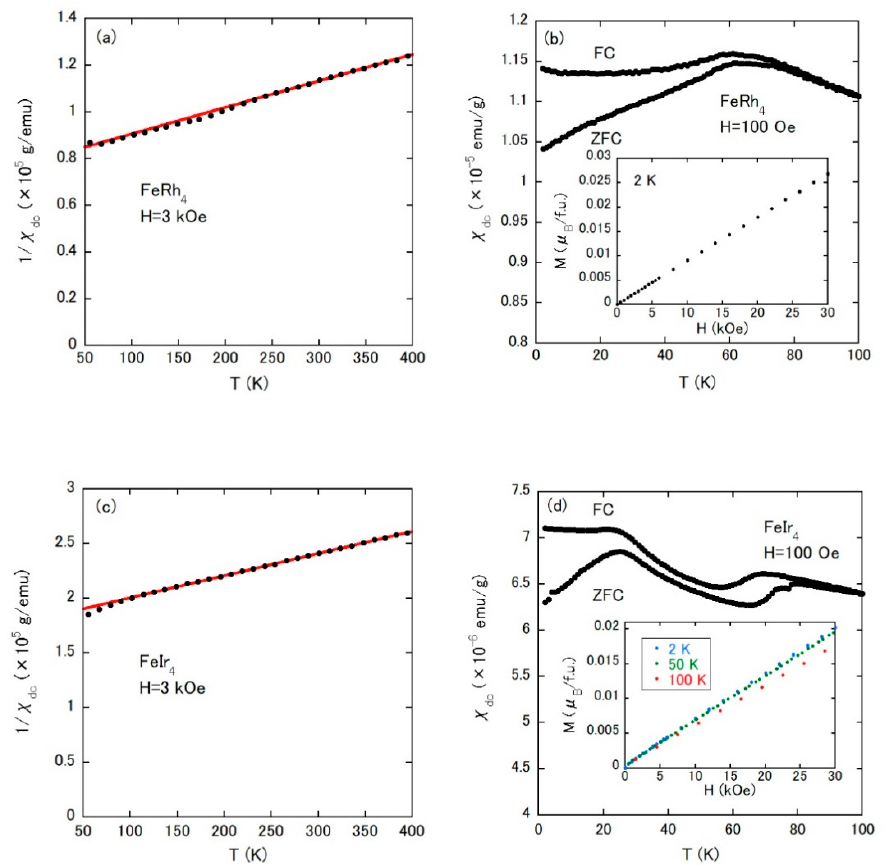
Figure 3. ( a ) Temperature dependence of 1/ χ dc under an external field of 3 kOe for FeRh 4 . ( b ) Temperature dependence of χ dc under ZFC and FC conditions with an external field of 100 Oe for FeRh 4 . The inset is the isothermal M – H curve at low temperature. ( c , d ) Experimental results of FeIr 4 , corresponding to ( a , b ), respectively. Table 2. Magnetism, magnetic ordering temperature, effective magnetic moment µ eff , Weiss temperature Θ CW , and electrical resistivity ρ at room temperature (RT) of prepared samples. SG, FM, and FM corr. refer to spin-glass, ferromagnetism, and ferromagnetic correlation below 300 K, respectively. T f and T C are spin-freezing and Curie temperatures, respectively. T f is the temperature where field-cooled magnetization under the external field of 100 Oe shows the hump.